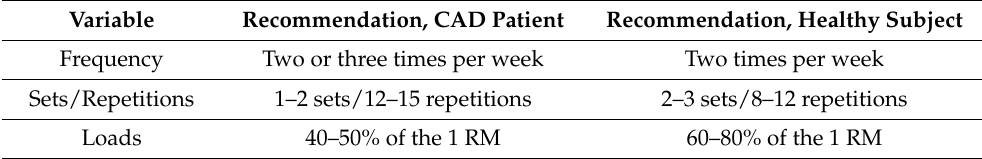
Table 5. Prescription of resistance